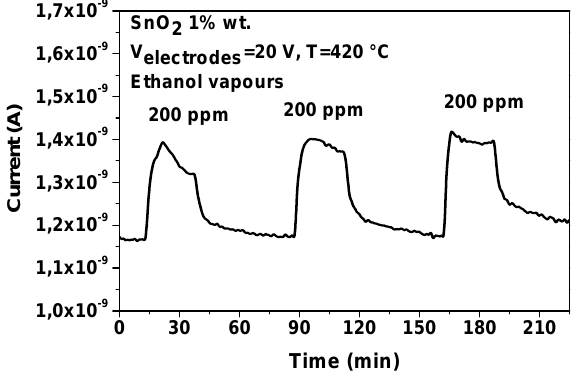
Figure 15 . Typical dynamic response of the MAPLE deposited SnO h annealing in air at 400 °C for concentrations of ethanol vapors of 200 ppm at the working temperature of 420